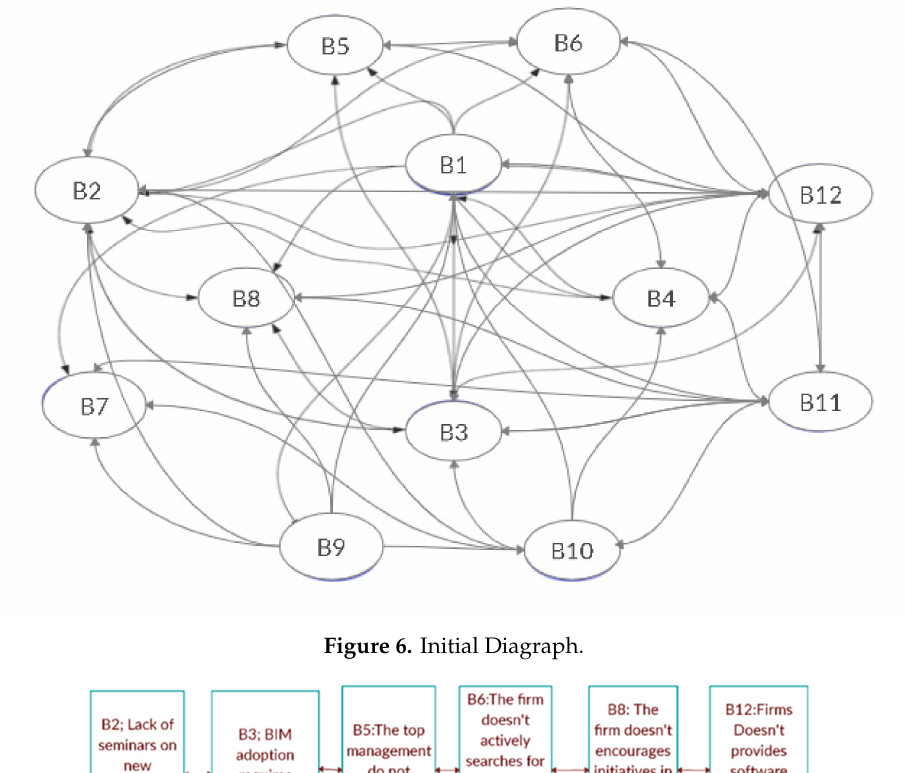
Figure 6. Initial Diagraph.